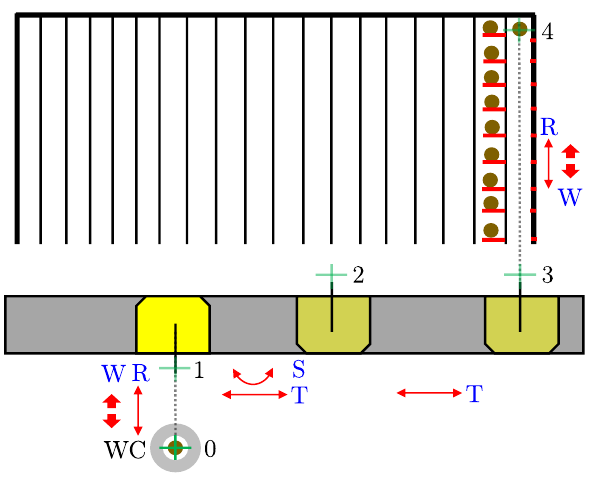
Figure 2: Operation sequence steps of the arms reach (R), winch (W), trolley (T), and slew (S), when mov- ing a drill-stand from the well-center to the de- sired fingerboard slot (simplified